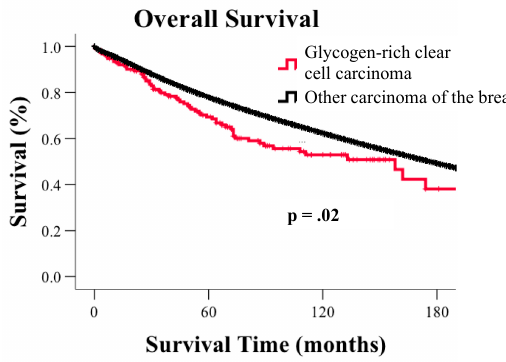
Figure 1. Kaplan-Meier curves for overall survival based on histological subtype. 177